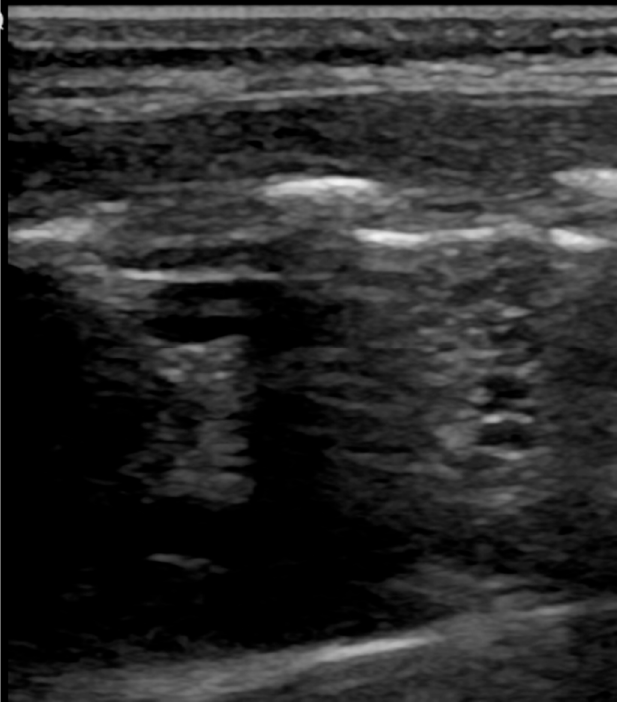
Figure 6. Congenital pulmonary airway malformations: multiple cystic lesions, not found in other pulmonary pathologies.